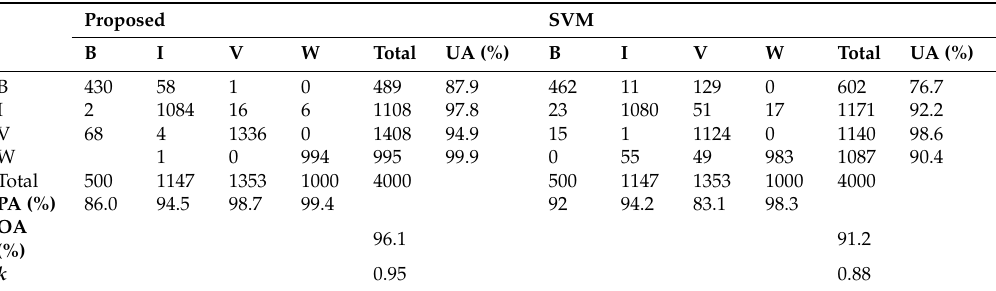
Figure 16. Classification of land cover in Hong Kong. Table 7. Accuracy of results for the Hong Kong